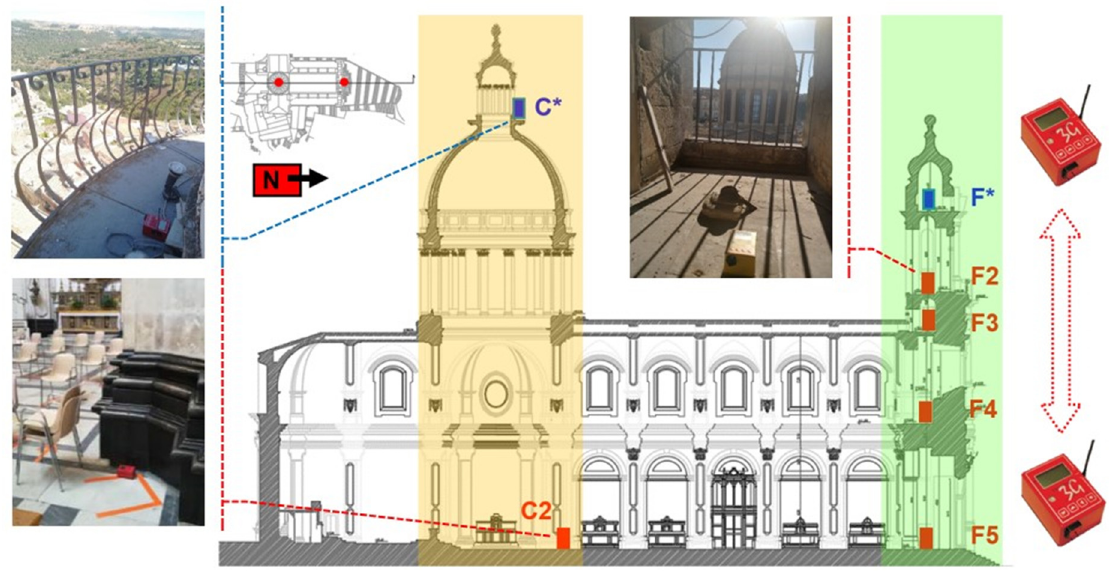
Figure 13. Monitoring scheme of the dome (yellow) and façade (green) and location of the Master (blue) and Rover (red) in the dome (C*–C2) and in the four setups carried out in the façade (F*–F2, F3, F4, F5).